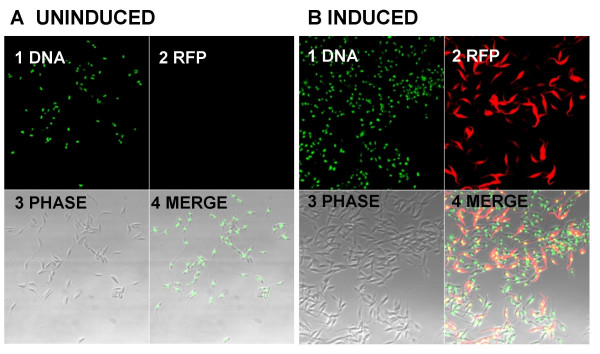
RFP expression in cloned cells by microscopy. Fluorescence microscopy of cloned pTcINDEX-RFP transformed epimastigotes before and after induction with tetracycline (5 μg ml-1). An aliquot was removed, and fixed every 24 hours for eight days. Cells were examined on a Zeiss LSM 510 microscope. Panel A shows the uninduced population and panel B the same culture 8 days after induction. In each case 1: DNA stained with TOTO-3 (green), 2: RFP expression (red), 3: phase image and 4 is a merged image.